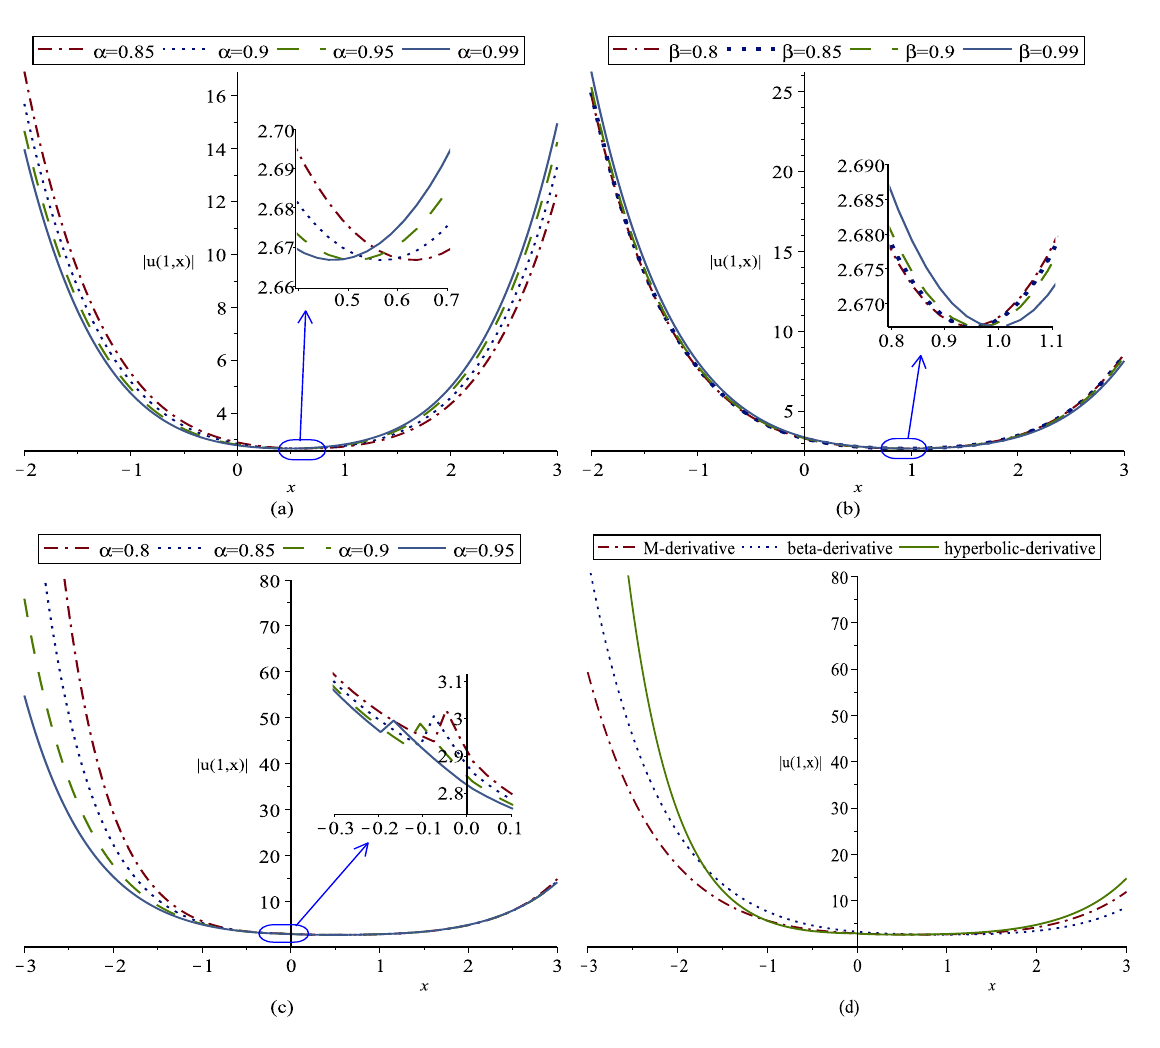
Figure 6. Exact solutions with k 1 = α 1 = a = c = 2, λ 1 = λ 2 = λ 3 = t = 1, m = 3, and ( a ) n = 1.5, β = 0.9, and various α w.r.t. M-derivative (21), ( b ) n = 2, and various β w.r.t. beta-derivative (21) ( c ) n = 2, and various α w.r.t. hyperbolic-derivative (21) ( d ) n = 2, α = β = 0.8, and various derivatives in